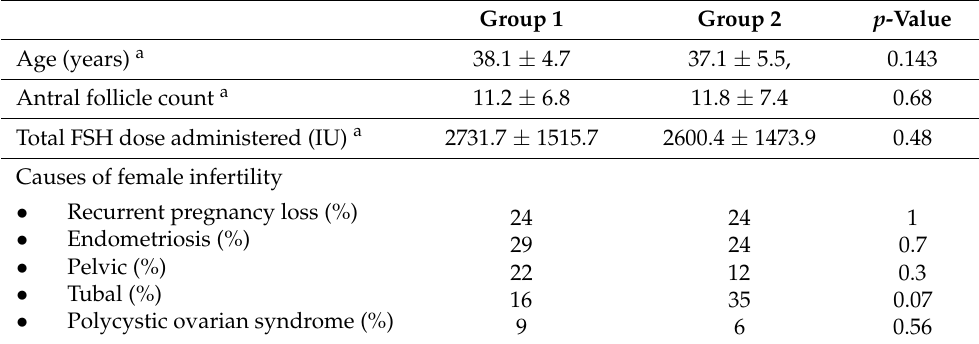
Table 1. Comparison of female characteristics between Group 1 and Group 2.